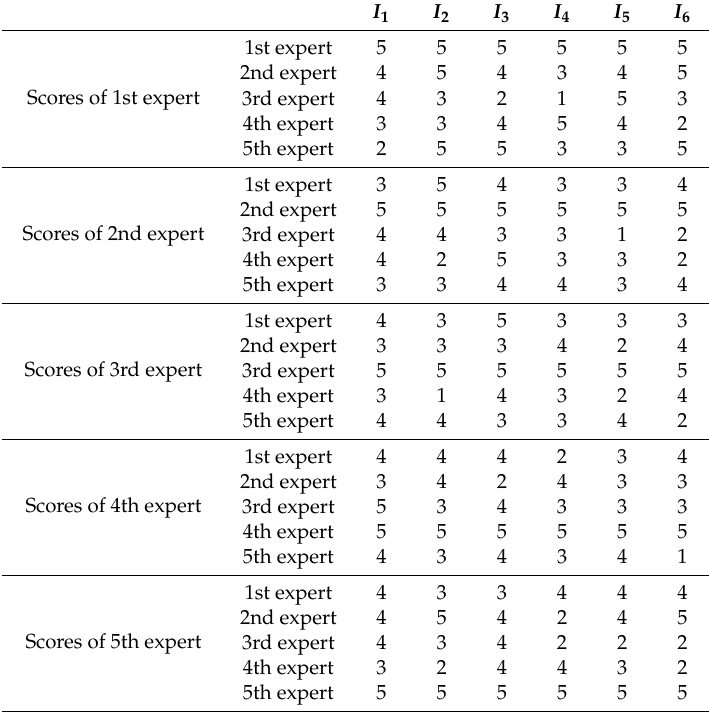
Table A8. Importance score set of each expert to others.